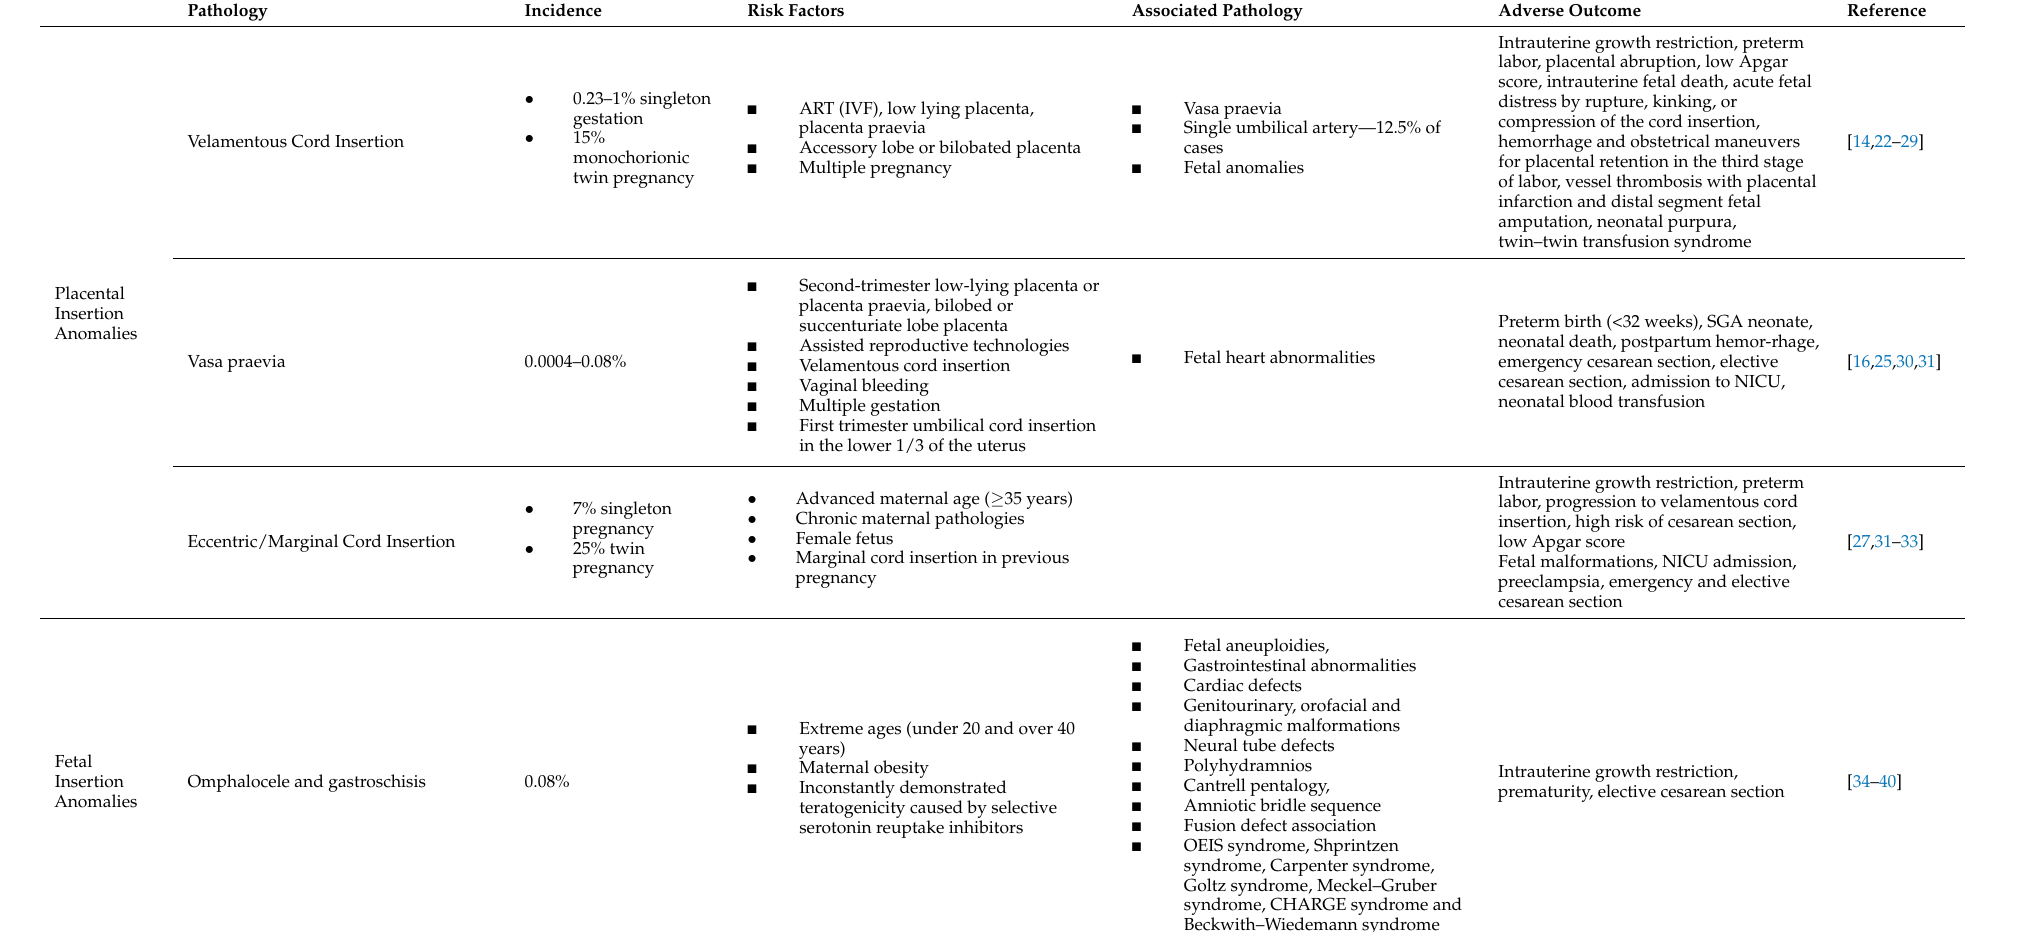
Table 1. General classification of